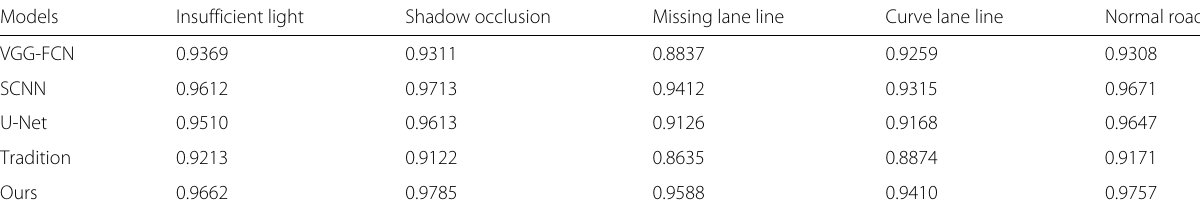
Table 1 Comparison of test results of different models